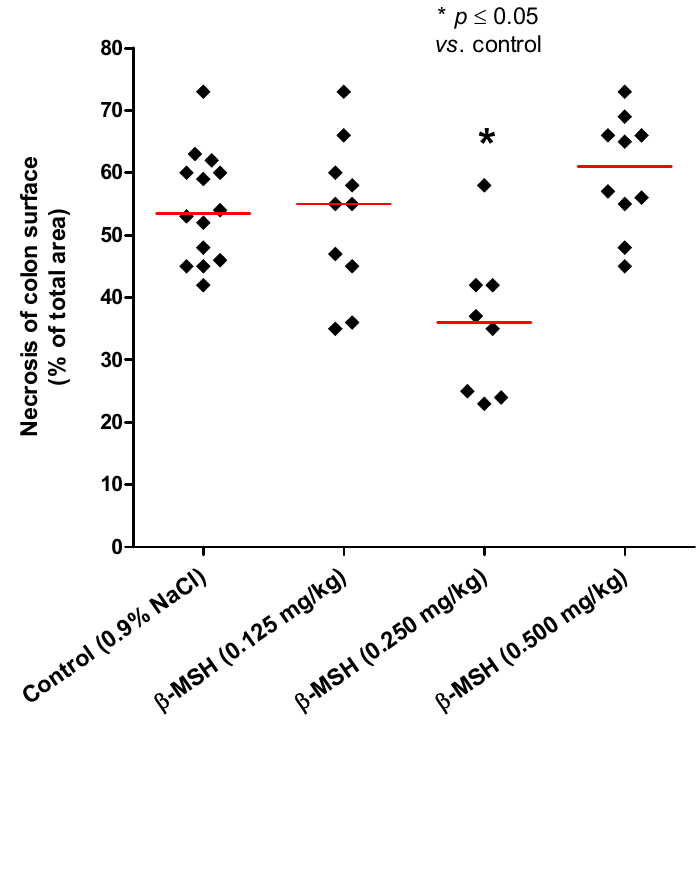
Figure 3. The area of colonic necrosis as a percentage of total colon area for individual animals in each experimental group. Diamonds represent individual values, and red lines denote median. p value is a result of comparison with the control group (Steel’s